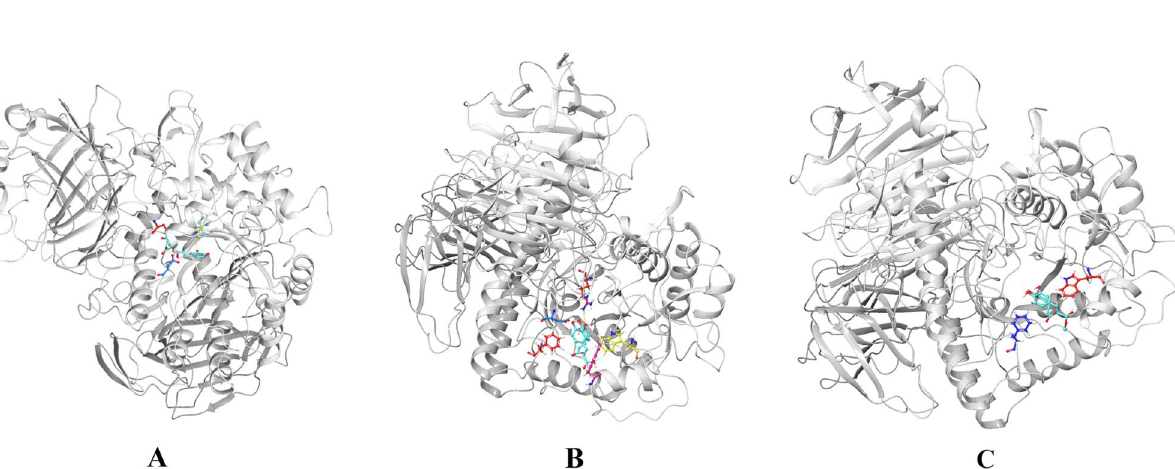
Table 3. The docking results of the five compounds to α-glycosidase. “–” means no.